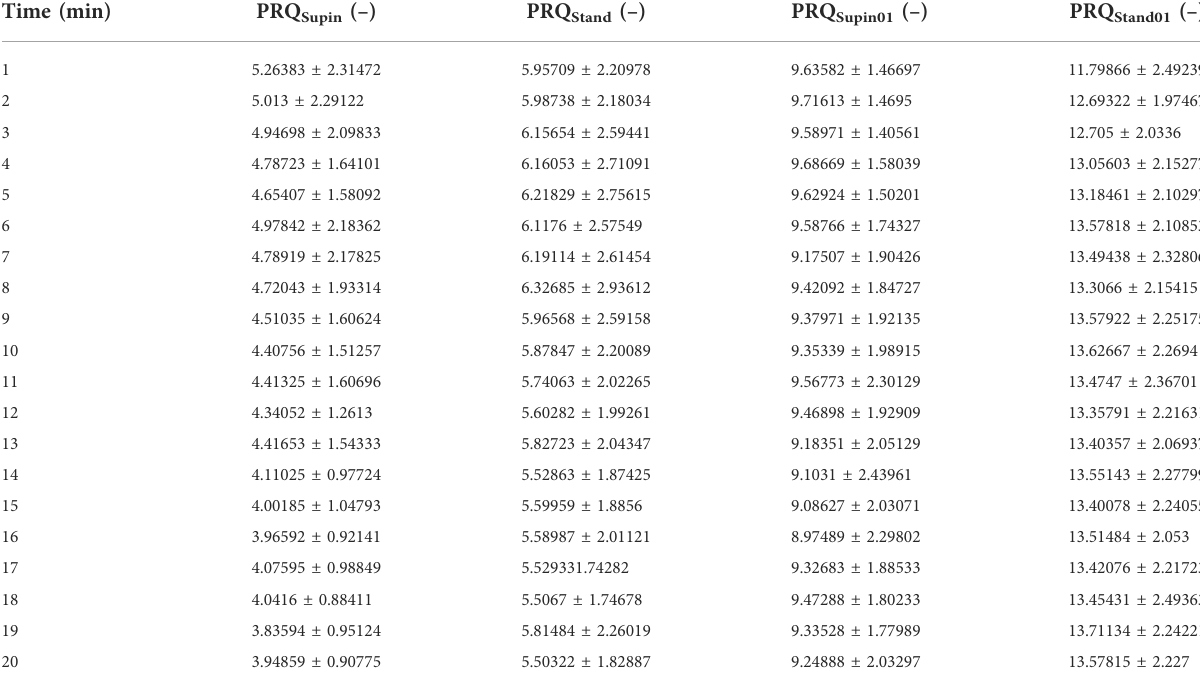
TABLE 3 Minute values of PRQ parameters (mean ± standard deviation), averaged for 20 subjects in four states. Supin — supine position with spontaneousbreathing,Stand — standingwithspontaneousbreathing,Supin01 — supinepositionwithslow(0.1 Hz)breathing,Stand01 — standing with slow (0.1 Hz)